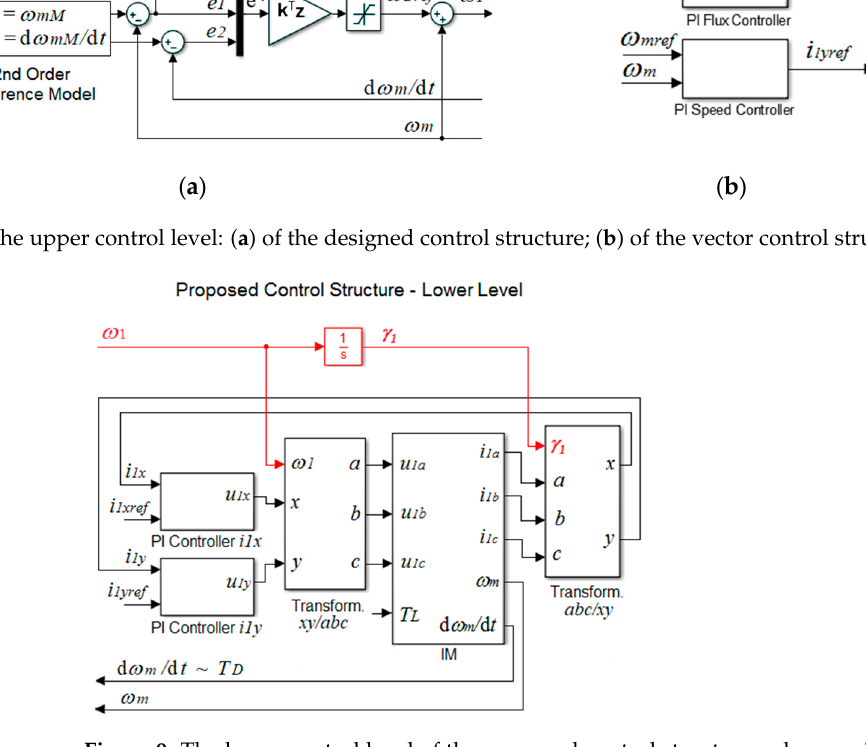
Figure 10. The lower level of the vector control structure, where γ is the actual position of the rotor flux vector.